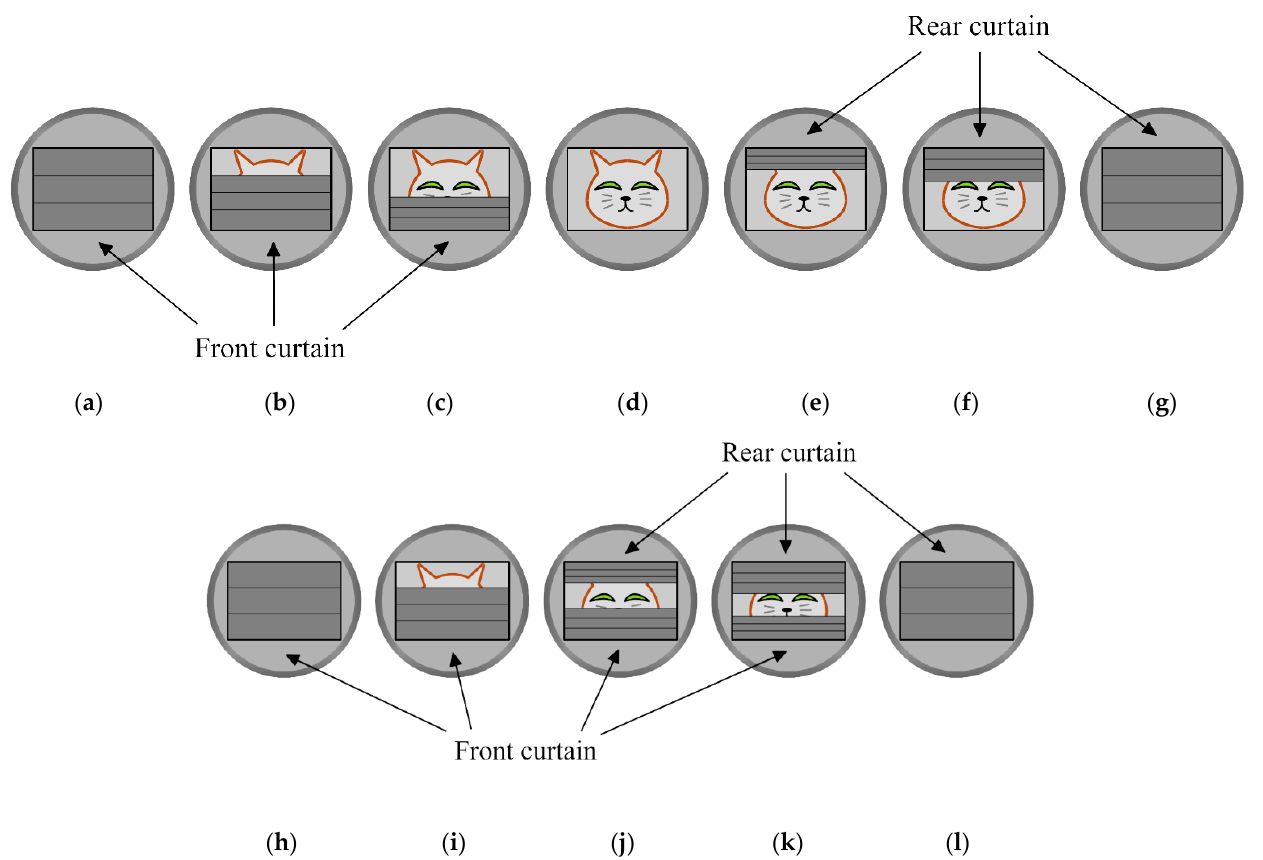
Figure 1. The operation of a mechanical focal plane shutter with two curtains. ( a – g ) long exposure time, the shutter is fully open, ( h – l ) short exposure time, the only a band in the shutter is open.